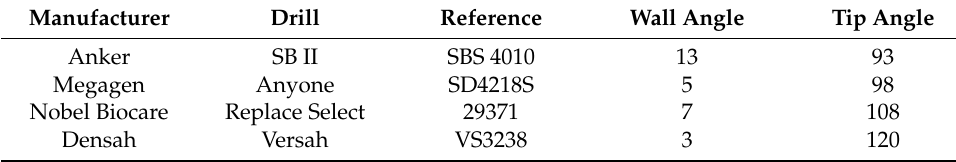
Table 1. Drill manufacturer, drill type, reference, wall angle, and tip